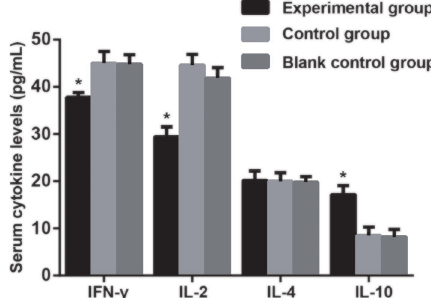
Figure 4. Serum levels of IFN- g , IL-2, IL-4 and IL-10 among the spinal tuberculosis (experimental), sham-operated (control) and blank groups. *P o 0.05 compared with the blank and sham groups